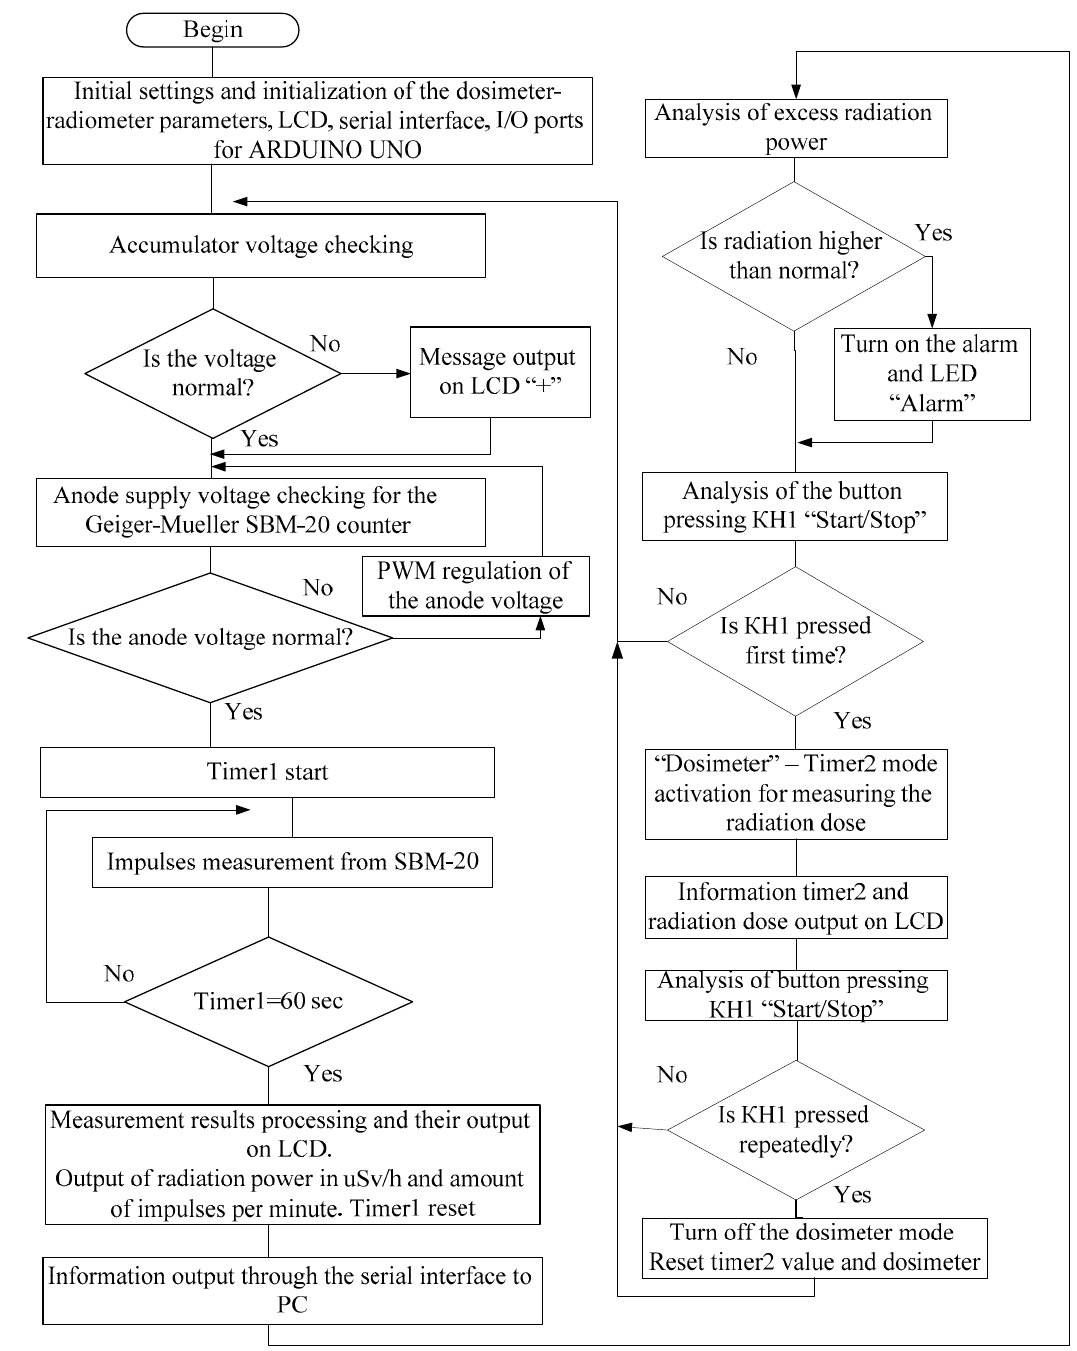
Figure 2. Operation algorithm of the microcontroller-based system for background radiation monitoring [15].